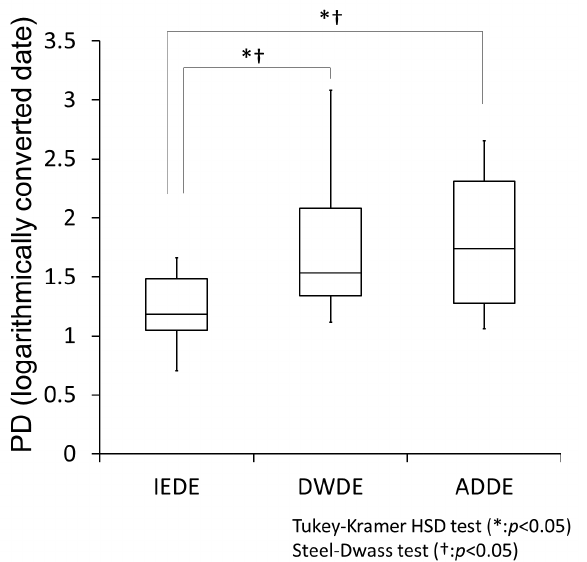
Figure 3. Box-and-whisker plot of minimum to maximum eye pain evaluated by PainVision ® . The evaluated eye pain is expressed by a Pain Degree (PD) index, and the logarithmic conversion of PD is shown in this figure. The base of the logarithm is 10. The box contains the lower quartile, the median, and the upper quartile for each DE subtype, and the minimum and maximum values are indicated by vertical bars. The Steel-Dwass test and the Tukey-Kramer HSD test were used for statistical analysis, and a p -value of < 0.05 was considered statistically significant.